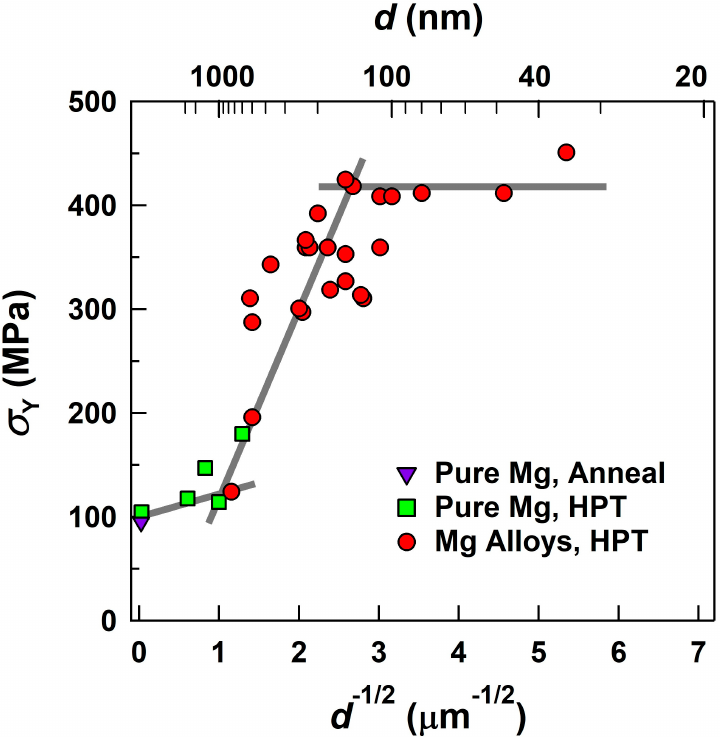
Figure 1. The Hall–Petch plot (yield stress, σ y , versus inverse square root of grain size, d ) and its breaks for magnesium and its alloys before and after severe plastic deformation by high-pressure torsion (HPT).